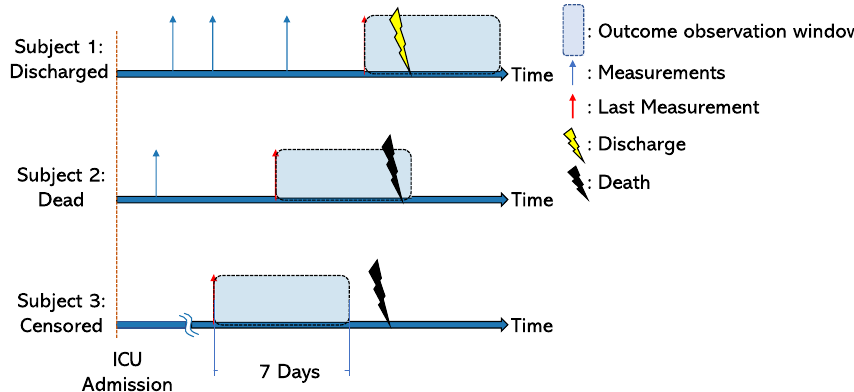
Figure 3. Study design. Each upward-pointing blue arrow represents a set of physiological variables (SBP, V T , PEEP, PaO 2 /FiO 2 , EtCO 2 , PaCO 2 ), recorded within a 1-h time window. Upward-pointing red arrows represent the last-recorded set of physiological variables. Lightning bolts are the outcomes in study (yellow for discharge from the Intensive Care Unit; black for death in the Intensive Care Unit); only outcomes recorded in a time window of 7 days since the last available measure (blue band) were considered valid for the purpose of the analysis. Subject 1 depicts a patient who was discharged from the Intensive Care Unit within 7 days since the last recorded set of physiologic variables. Subject 2 shows a patient who died within 7 days since the last measured set of data. Subject 3 depicts a patient who experienced the outcome (death) beyond the time window of 7 days since the last recorded set of measurements; data from patients like Subject 3 were censored. EtCO 2 end-tidal partial pressure of carbon dioxide, PaCO 2 arterial partial pressure of carbon dioxide, PaO 2 /FiO 2 ratio of arterial oxygen partial pressure (PaO 2 ) to fractional inspired oxygen (FiO 2 ), PaO 2 arterial oxygen partial pressure, PEEP positive end-expiratory pressure, SBP systolic blood pressure, V T set or measured tidal